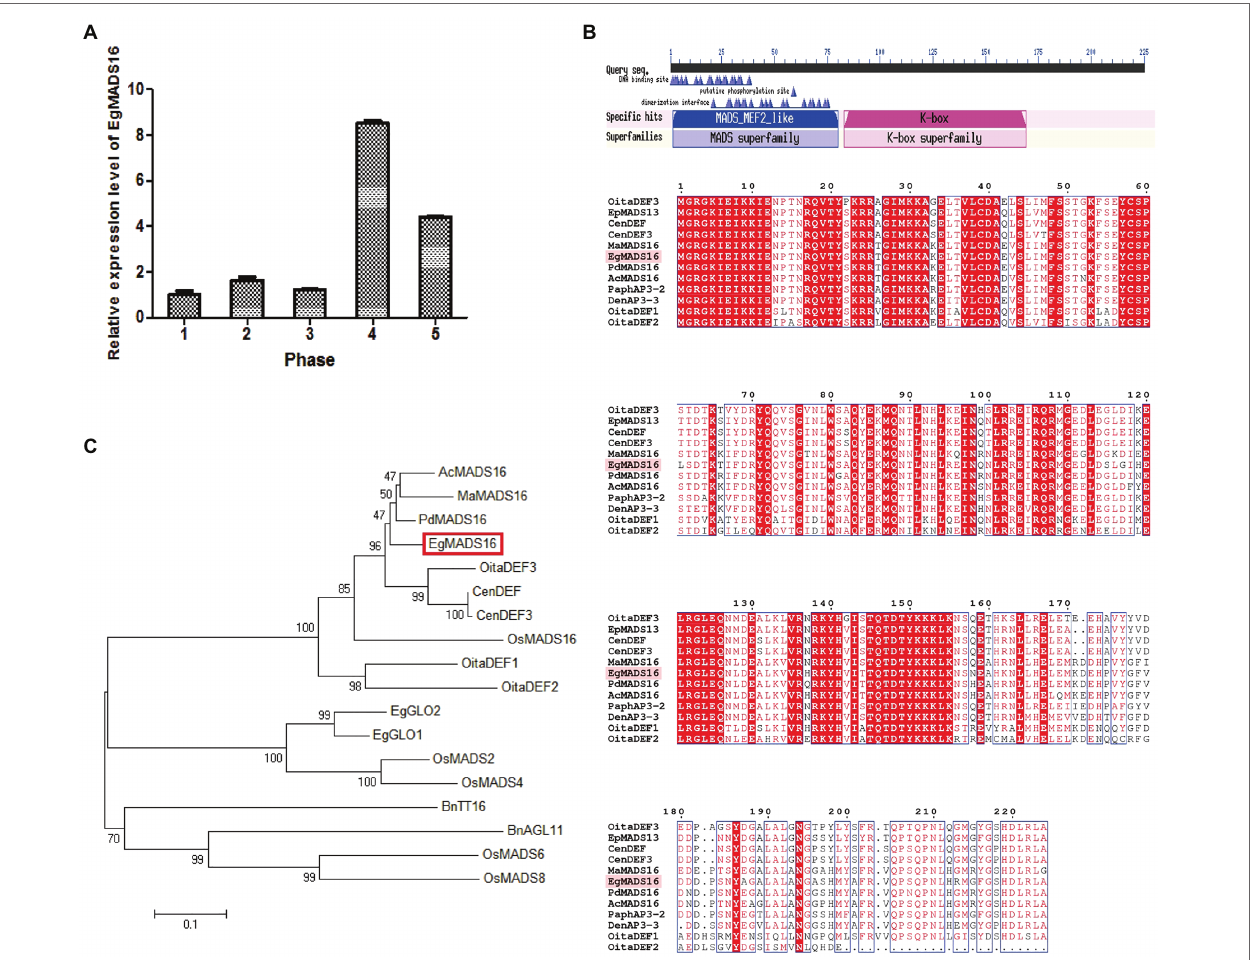
FIGURE 1 | The expression patterns and sequence analysis of EgMADS16. (A) The relative expression level of EgMADS16 in different developmental stages of oil palm fruit mesocarp. Phase 1–5: fruits 30–60 days, 60–100 days, 100–120 days, 120–140 days, and 140–160 days after pollination. The values are the means±SD ( n = 3). (B) Conserved domains analysis of EgMADS16 protein. (C) The phylogenetic tree of EgMADS16 and other MADS proteins, including EgGLO1 (XP_010911271.1), EgGLO2 (AAQ03229.1), OsMADS2 (XP_015623988.1), OsMADS4 (XP_015640709.1), OsMADS6 (XP_015623947.1), OsMADS8 (XP_015610824.1), OsMADS16 (XP_015641661.1), AcMADS16 (XP_020082339.1), BnAGL11 (XP_013719732.1), BnTT16 (NP_001303188.1), CenDEF (ALB26780.1), CenDEF3 (AFH66787.1), OitaDEF1 (BAO00916.1), OitaDEF2 (BAO00917.1), OitaDEF3 (BAO00918.1), MaMADS16 (XP_009418316.1), and PdMADS16